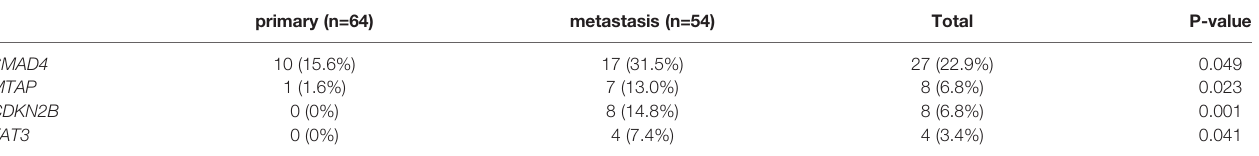
TABLE 2 | Detailed patient number and the mutational frequency.